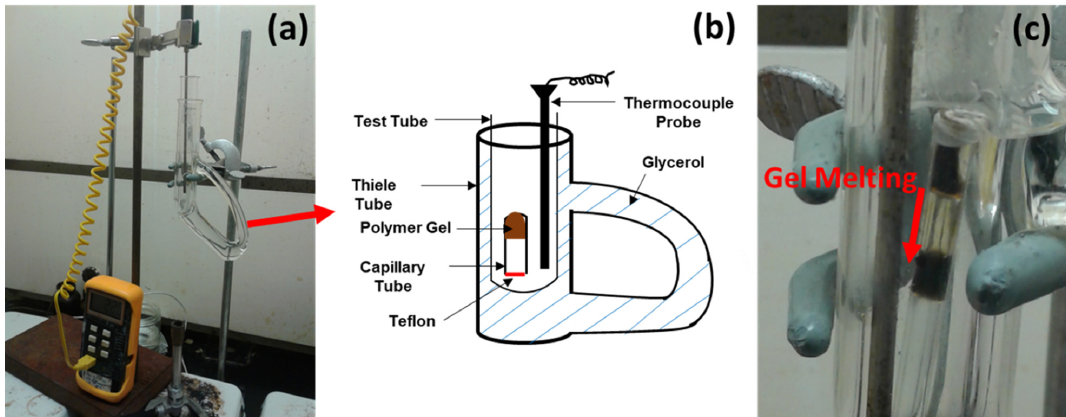
Figure 2. The testing set-up for measuring gel-melting is photographed in ( a ) along with an illustra- tion of the Thiele tube ( b ). The test tube housed the glass capillary tube of gel and the